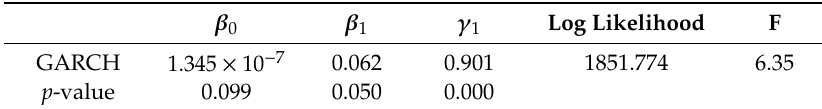
Table 5. Estimation of expected normal return for exchange rate and its volatility according to the GARCH(1,1) model during the period of the estimation window.